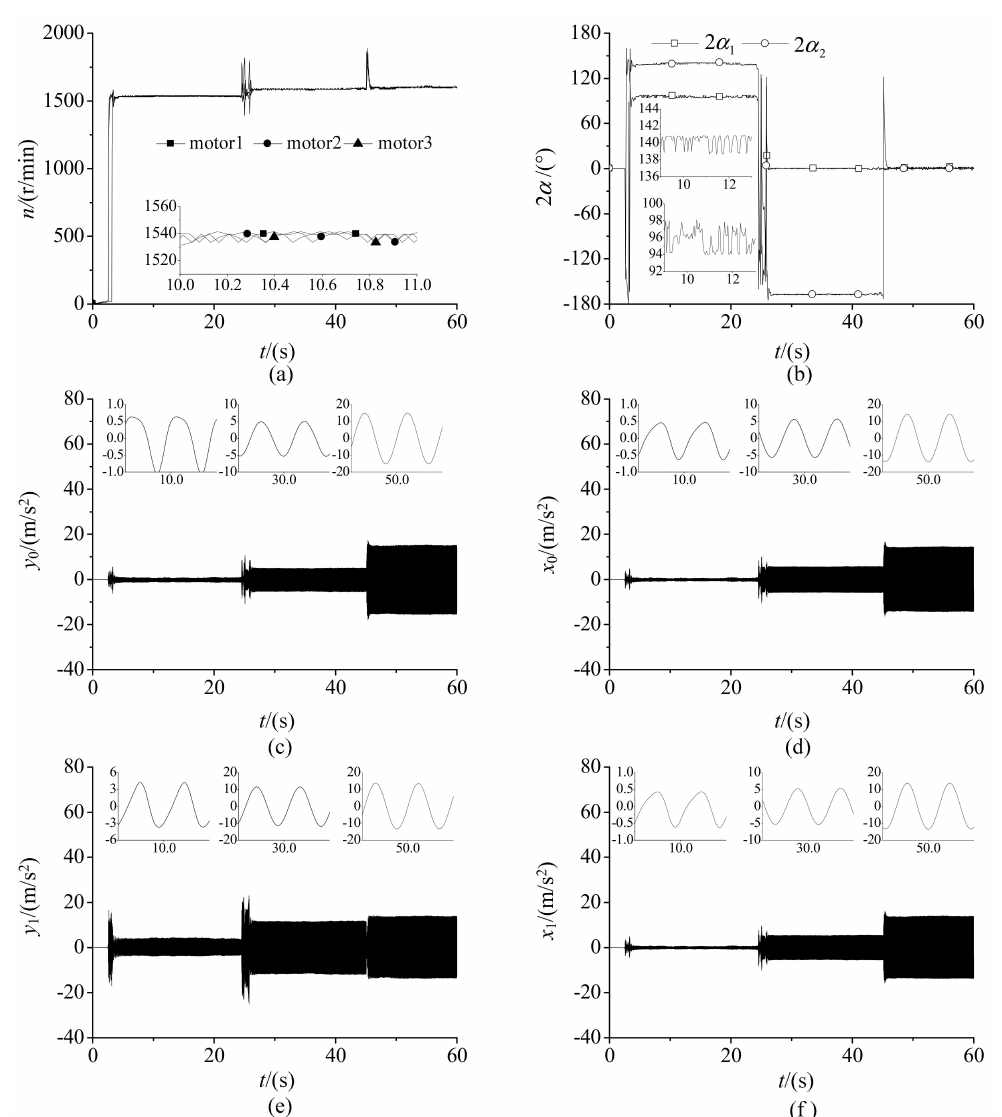
Figure 11. Comparing vibration synchronization and control synchronization: ( a ) the velocities of three motors; ( b ) the phase differences; ( c ) acceleration amplitude of the mass center in y -direction; ( d ) acceleration amplitude of the mass center in x -direction; ( e ) acceleration amplitude of the edge position in y -direction; ( f ) acceleration amplitude of the edge position in x